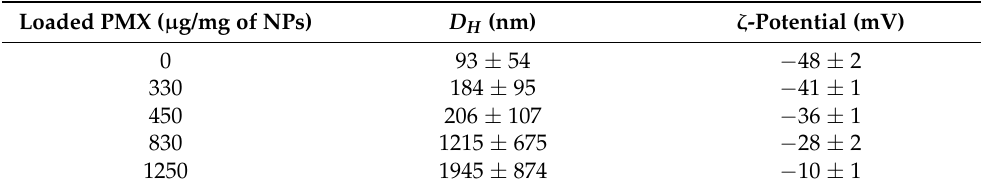
Table 3 . Changes in characteristics of hybrid PGlu@Ag NPs after loading of polymyxin B. Loaded PMX (µg/mg of NPs)